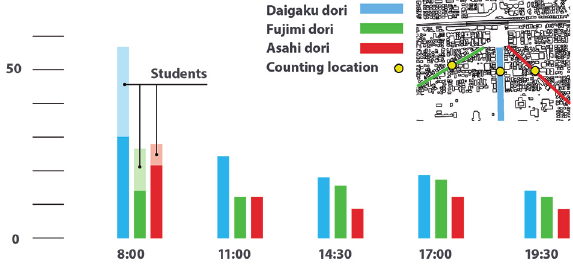
Figure 5. “Gate” method counting of pedestrian frequency on-site